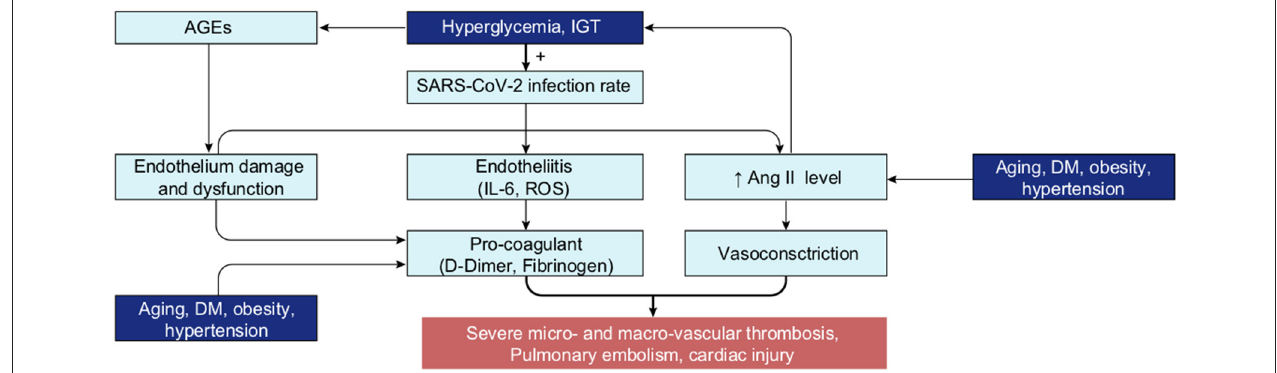
FIGURE 26 | Schematic of SARS-CoV-2 infection in endothelial cells in patients at risk, and the subsequent mechanisms leading to the thrombotic events. Endothelial cells are expressing the receptor ACE2 and then are direct target for SARS-CoV-2 infection once it has reached the vascular system. Direct consequences of endothelial cells infection are the endothelium damage and dysfunction, endothelium inflammation (endotheliitis), both leading to the activation of a pro-coagulant state. Other consequence of SARS-CoV-2 infection is the increased production of Ang II (as consequence of ACE2 inactivation after internalization), with a vasoconstriction effect. The combination of the activation of pro-coagulation and vasonconstriction is then associated with a high risk of thrombotic events. The majority of patients at risk present a pre-existing pro-coagulant state due to (1) hyperglycemia-induced increase in AGEs production, (2) increased level of pro-coagulant factor such as fibrinogen. In addition, all group at risk are also described to present a pre-existing increased level of Ang II. Then, the presence of these pre-existing conditions (pro-coagulant factors and Ang II level) easily explain the increased risk of thrombotic events upon SARS-CoV-2 infection in these groups of patients. Moreover, and as previously described, the majority of patients at-risk for COVID-19 presents a hyperglycemia or an IGT that increase the viral replication rate in cells. Then, these patients may also present an increased infection rate in their endothelial cells further amplifying the associated events above described. Hence, this schema highlights why these specific groups of patients present a high proportion of severe micro and macro-vascular thrombotic events upon SARS-CoV-2